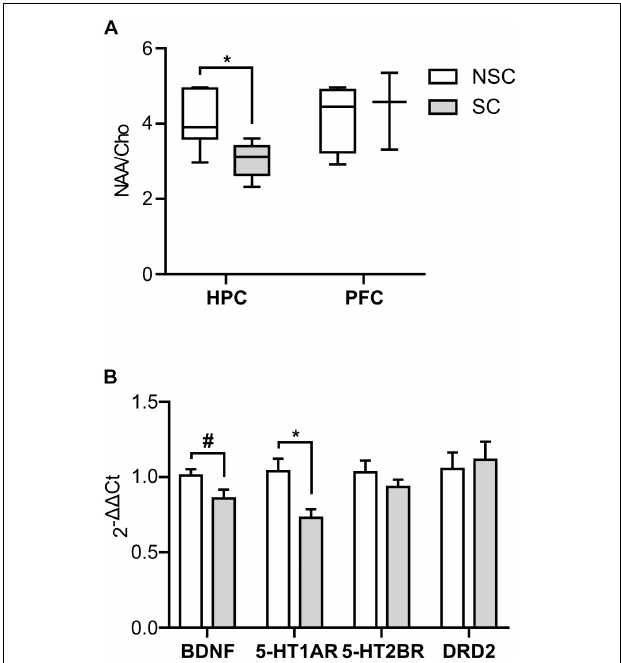
FIGURE 4 | Neurophysiology (single voxel spectroscopy and molecular biology). The NAA/Cho ratio was lower in the hippocampus (HPC) of stressed (SC) compared to non-stressed (NSC) animals ( U = 3.000, p = 0.015), but no difference was found in the prefrontal cortex (PFC) (A) . N = 6/group (HPC) and n = 3/group (PFC), boxplot, Mann–Whitney. In the hippocampus there was a trend for a lower level of BDNF [ F (1,20) = 4.125, p = 0.056] and a significantly lower level of 5-HT 1 A R [ F (1,18) = 7.959, p = 0.007] in SC animals (B) . N = 12/group, mean ± SEM, two-way ANOVA, # p < 0.1, ∗ p <